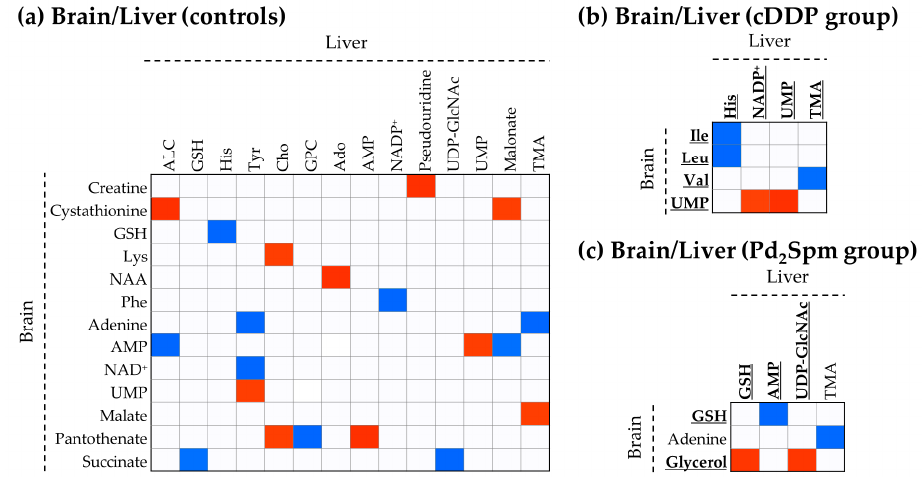
Figure 6. Spearman correlations between significant variations between liver and brain of ( a ) controls and groups treated with ( b ) cDDP or ( c ) Pd 2 Spm, regarding an absolute correlation coefficient of 0.80. The correlations are statistically significant, exhibiting p -values between 0.05 and 0.01. Bold and underline metabolites represent new correlations regarding those found in controls. Abbreviations as defined in Figures 1, 4 and 5.